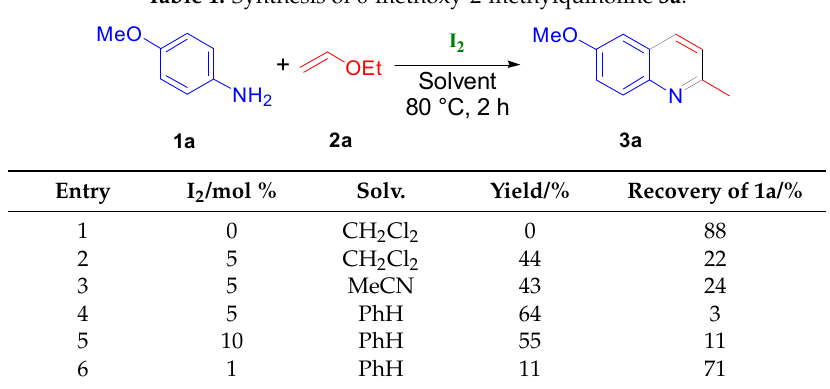
Table 1. Synthesis of 6-methoxy-2-methylquinoline 3a .